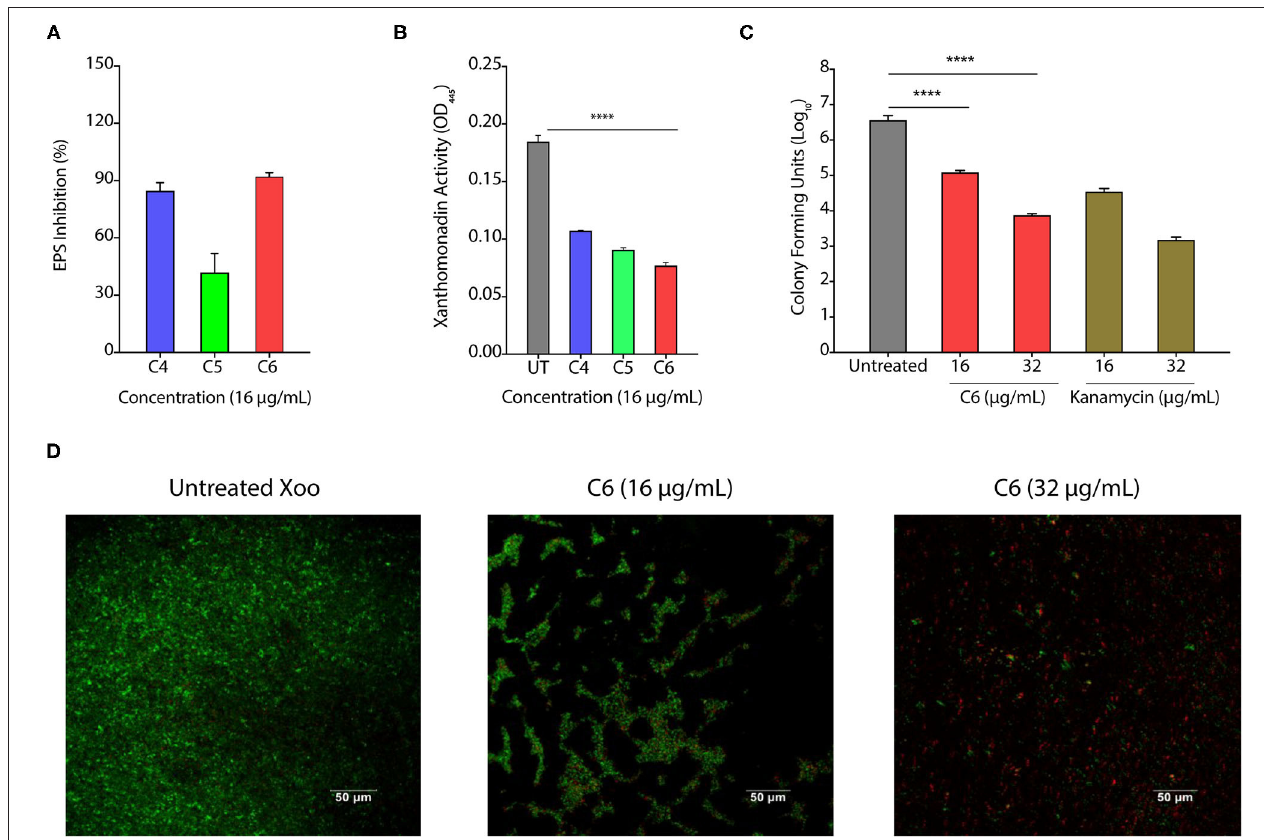
FIGURE 3 | CAGCs can degrade bacterial biofilms. (A, B) Percentage change in exopolysaccharide substance (EPS) (A) and change in Xanthomonad content ( α = 0.05, **** p < 0.0001) (B) after treatment with C4 , C5 , and C6 CAGCs. (C) Change in CFUs of Xoo biofilms before and after treatment with C6 and Kanamycin after 7 days of treatment (**** indicates p < 0.0001). Statistical significant difference between indicated groups at p < 0.001 (estimated by one-way ANOVA). (D) SYTO-PI-stained fluorescence micrographs of untreated and C6 treated Xoo biofilms. Confocal microscopic images were taken after 7-days